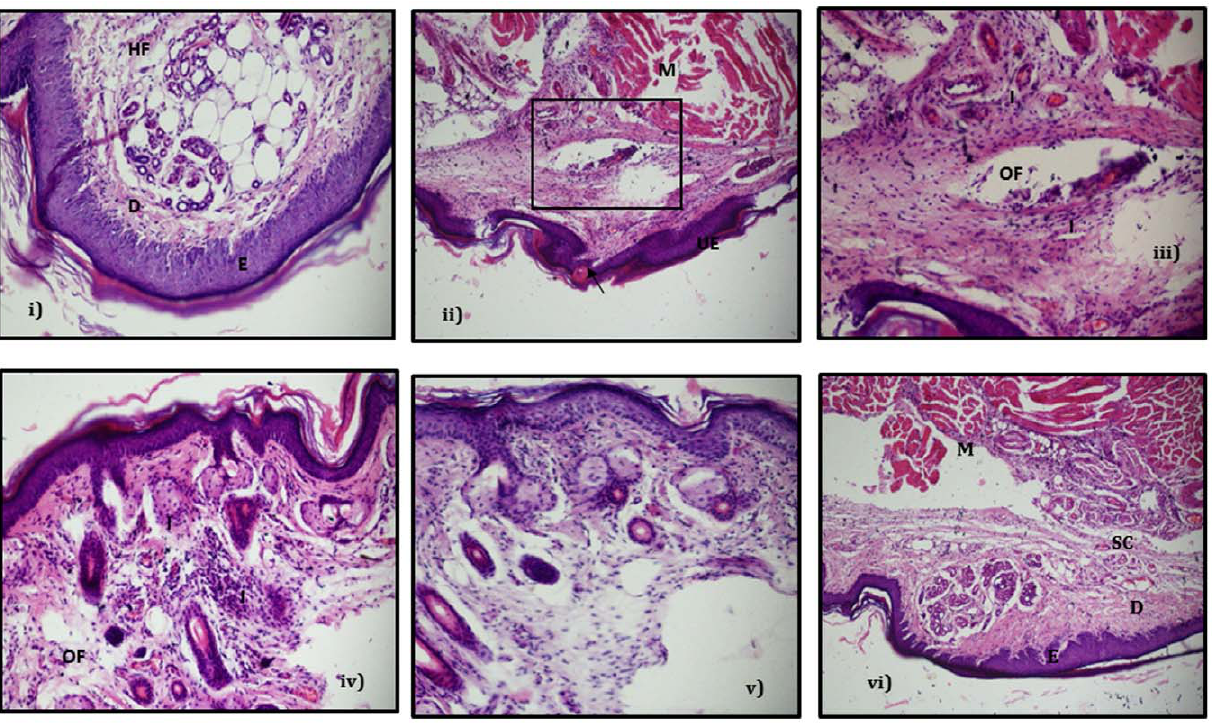
Figure 6. Histopathological examination of infected and treated hindpaws of diabetic mice. Photo micrograph of i) Normal skin showing intact epithelial layers(E,D,M) sebaceous glands and intact hair follicles(HF) (H and E 200X) ii) Skin tissue from hindpaw of infected diabetic mice showing fairly heavy inflammation(I) involving the dermis and extending deep into muscle (H and E 100X) iii) Magnified view of the area (denoted in the rectangular panel in (ii) showing heavy infiltration of polymorphoneutrophils (I) and collection of oedematous fluid in the subcutaneous areas iv) Skin tissue from hindpaw of infected diabetic mice treated with phage MR-10 alone showing moderate inflammation and infiltration (I) is visible with oedema (OF) seen in some areas v) Skin tissue from hindpaw of infected diabetic mice treated with linezolid showing mild inflammatory areas and vi) Skin tissue from hindpaw of infected diabetic mice treated with phage MR-10 and linezolid (in combination) showing normal skin layers with significant reduction in inflammation. ( E -epidermis, D -dermis, SC -subcutaneous layer, M -muscle layer, OF -oedema fluid accumulation, UE -ulcerated epridermis, arrow - abscess in epidermal layer, I –infiltrating neutrophils).